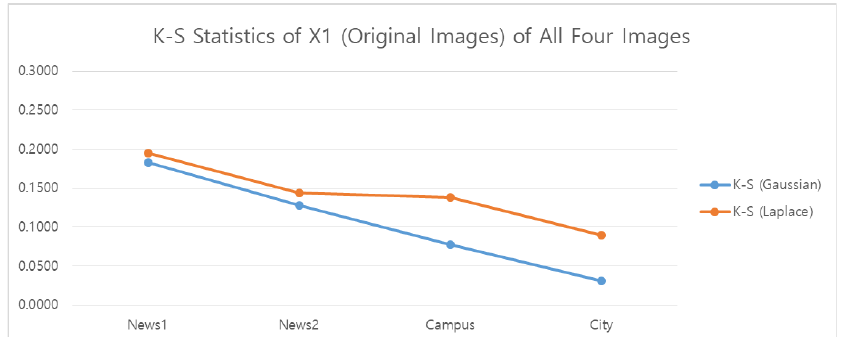
Figure 14. Kolmogorov-Smirnov Test Statistics for